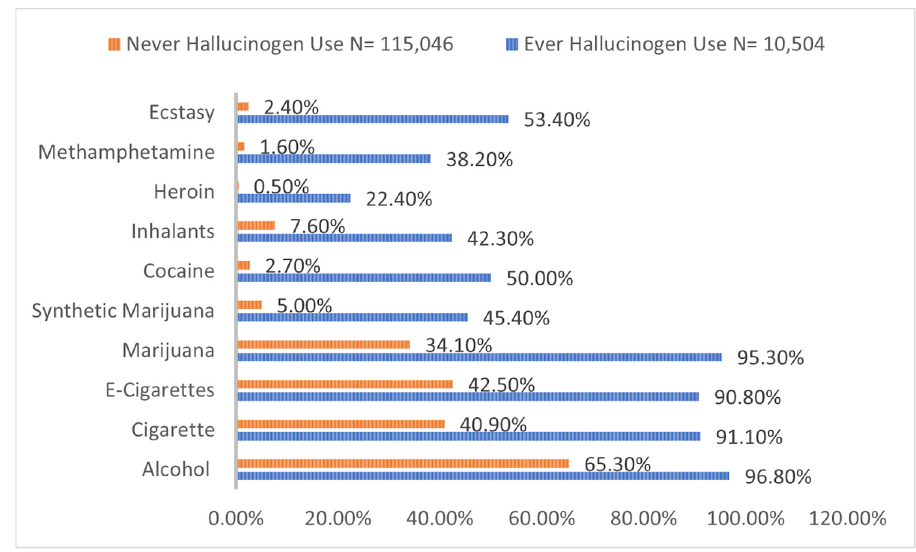
Figure 3. Prevalence of co-occurring substance use in adolescent hallucinogen users.